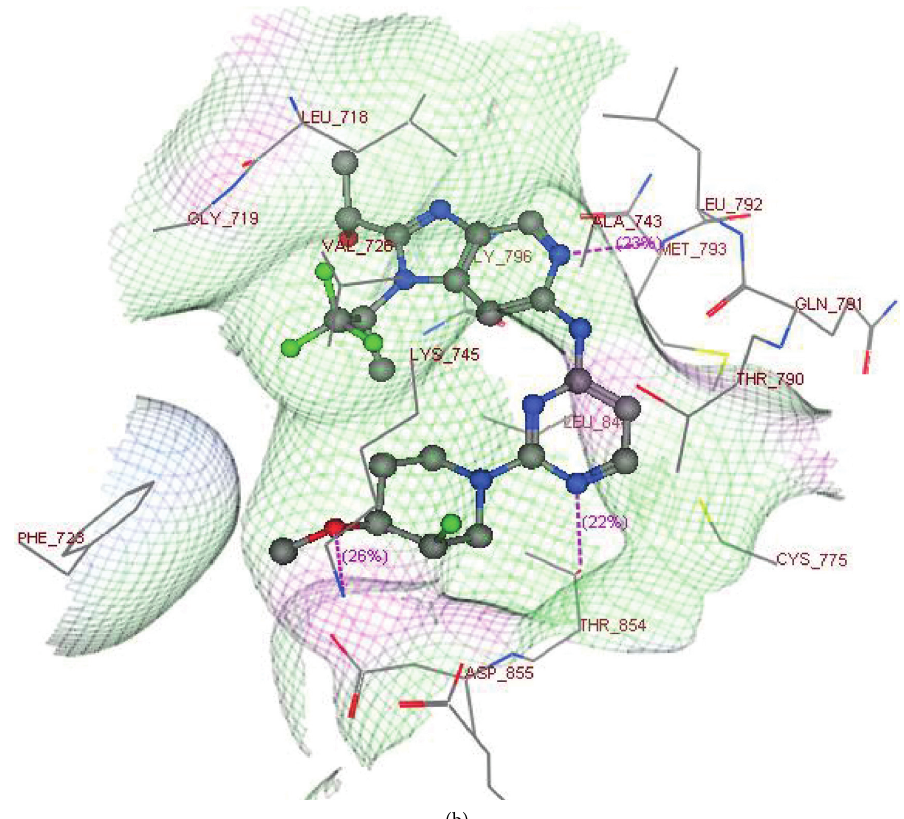
Figure 3: (a) The 2D depiction of the docked conformation of co-crystallized ligand (4ZQ) in the EGFR protein (PDB ID: 5CAV) binding site. (b) The 3D depiction of the docked conformation of co-crystallized ligand (4ZQ) in the EGFR protein (PDB ID: 5CAV) binding